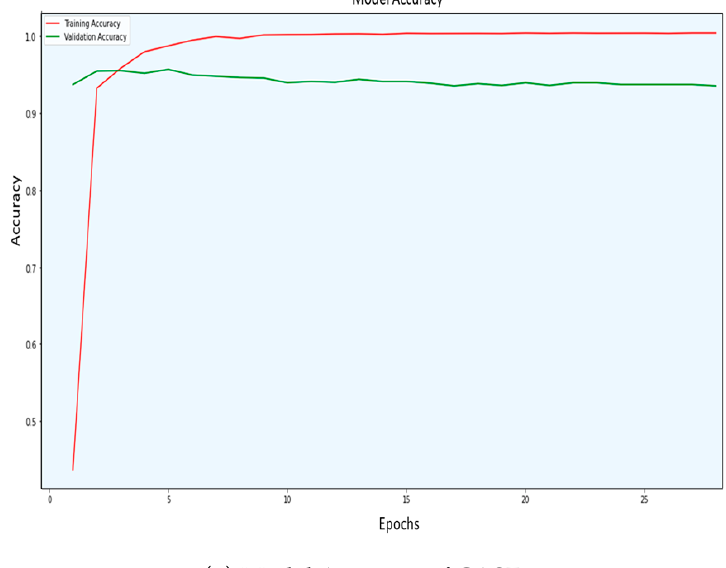
( a ) Model Accuracy of CASE Figure 10. Cont